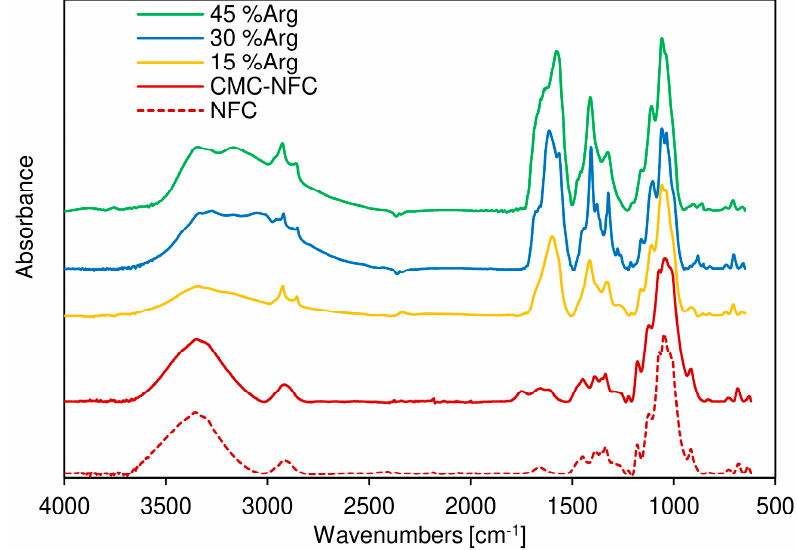
Figure 6. Fourier-transform infrared (FTIR) spectra of plain cellulose, carboxymethylated nanocellulose, and the CMC-NFC/arginine blends.